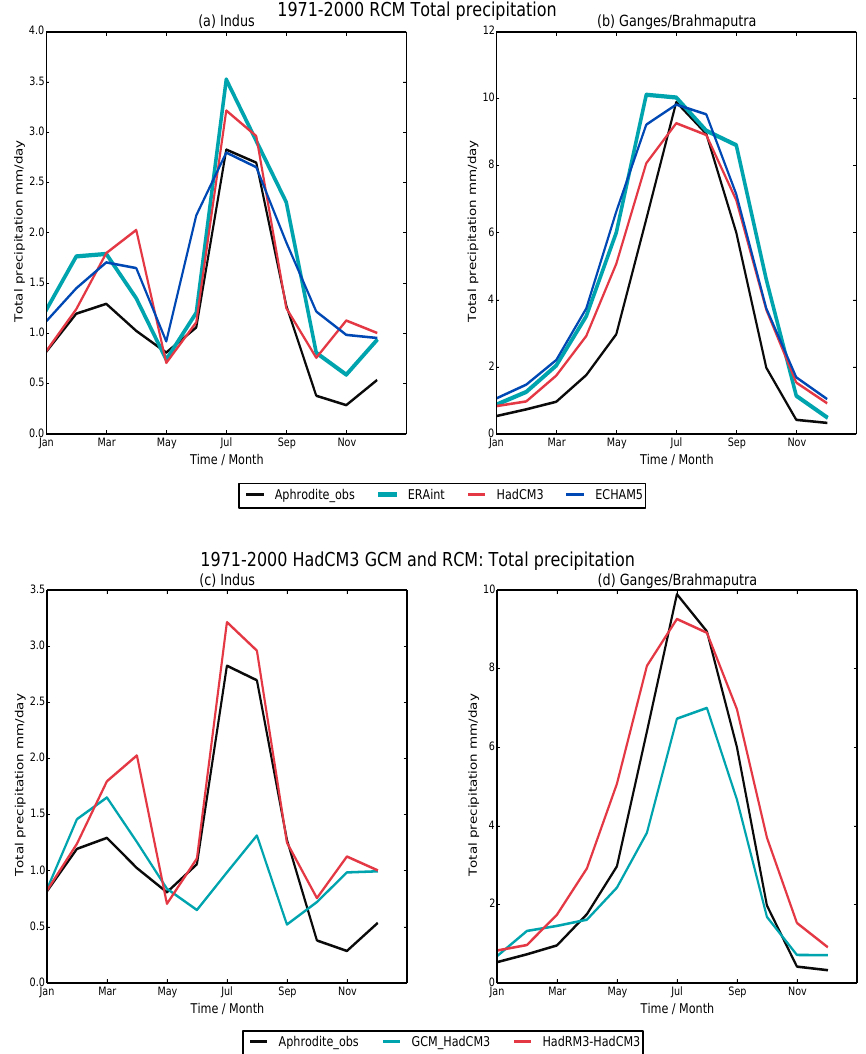
Figure 6. Seasonal cycle of total precipitation for the Indus (a, c) and Ganges–Brahmaputra (b, d) catchments. The RCM simulations are shown in (a) and (b) (HadCM3 – red, ECHAM5 – blue, ERAint – cyan lines). A comparison of the HadCM3 GCM (cyan line) and HadCM3-HadRM3 (red line) seasonal cycles are shown in (c) and (d) . APHRODITE observations are also shown (black line) on all